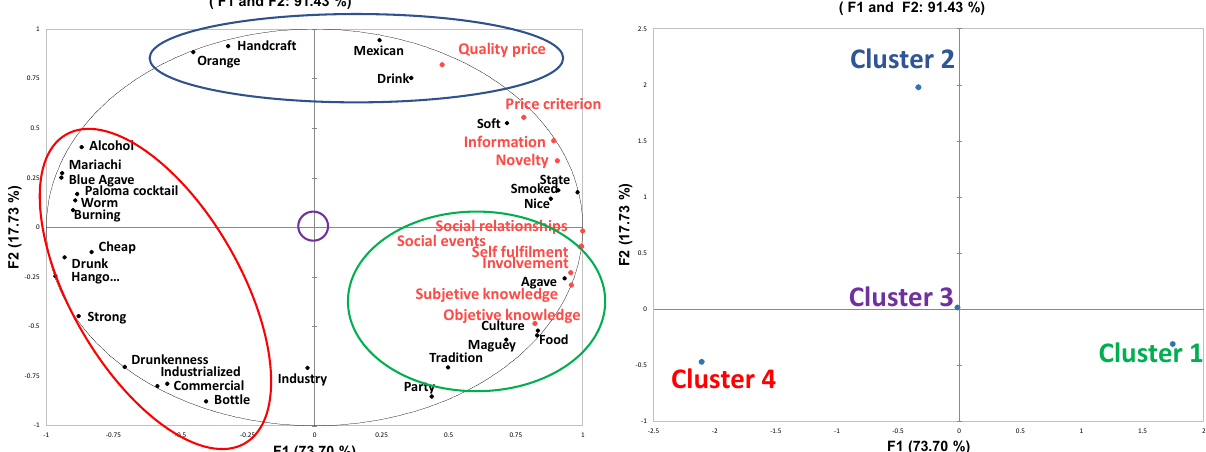
Figure 1. Relationship among the assessed constructs and selected terms according to clusters.